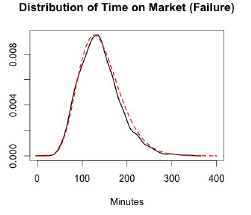
Figure 7. Distribution of the probability of being invited to purchase from a private dealer, conditional on successfully purchasing heroin via a street broker. The black line represents the density of the invite probability across all customers within each 1- hour interval of market activity based on 100 simulations of the market from days 180 to 365. The dashed red line represents a fitted distribution, which is a Beta (0.55,7.45) distribution.